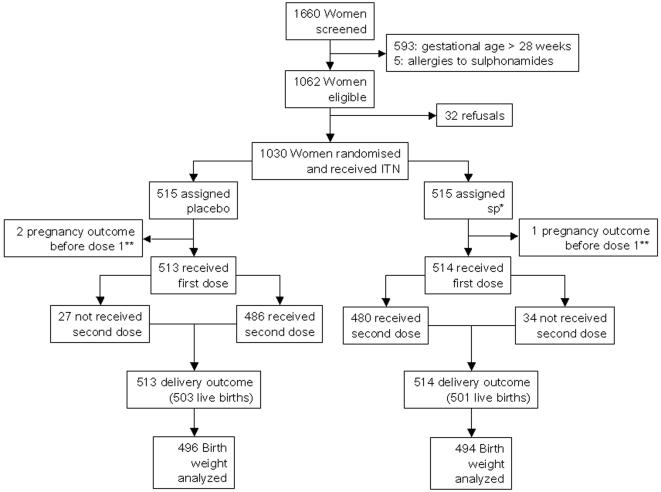
Trial profileThere were 3 and 7 twins births in the SP and placebo groups respectively. There was one triplet birth in the SP Group.* sulphadoxine-pyrimethamine ** 1 woman in the SP group and 2 in the placebo group had a miscarriage before receiving dose 1